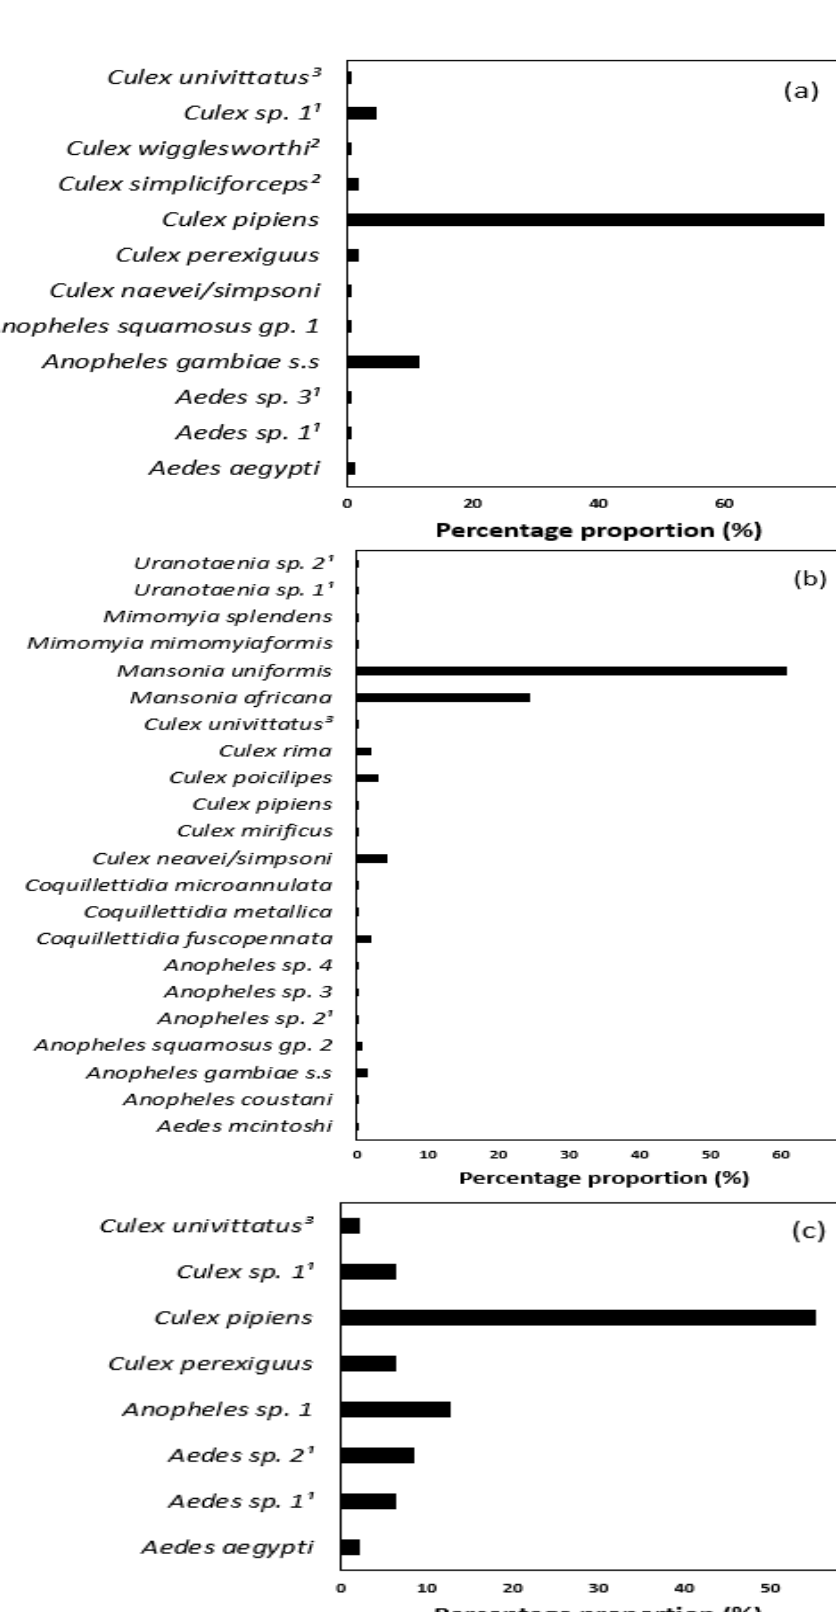
Figure 2. Summary of the diversity proportions (percentage) of mosquito species sampled from the ( a ) Chobe enclave, ( b ) Okavango and ( c ) Central Kalahari Game Reserve (CKGR) between March 2019 and February